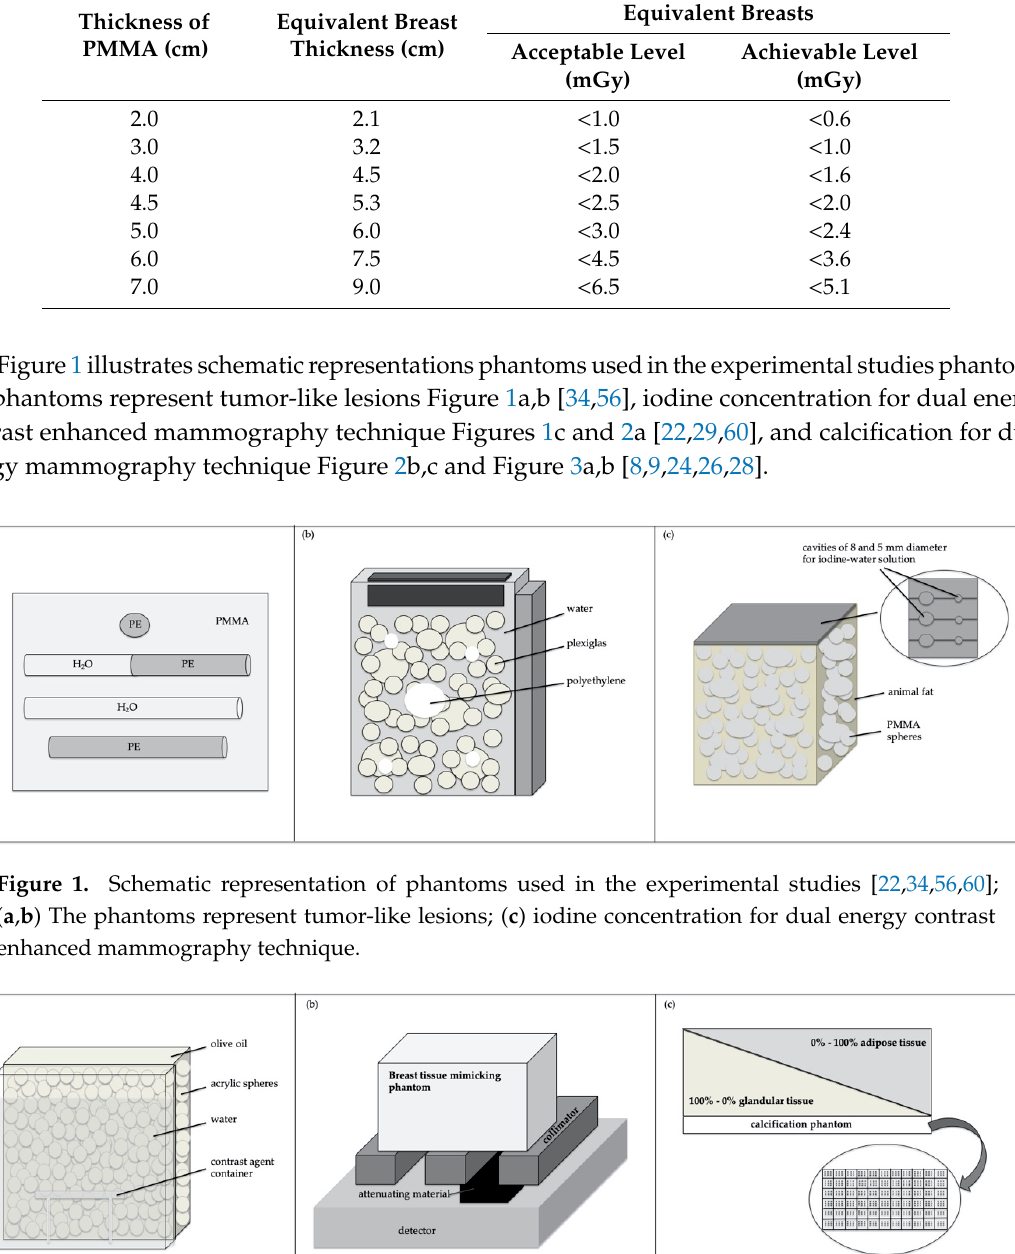
Table 2. European Guidelines for maximum average glandular doses.